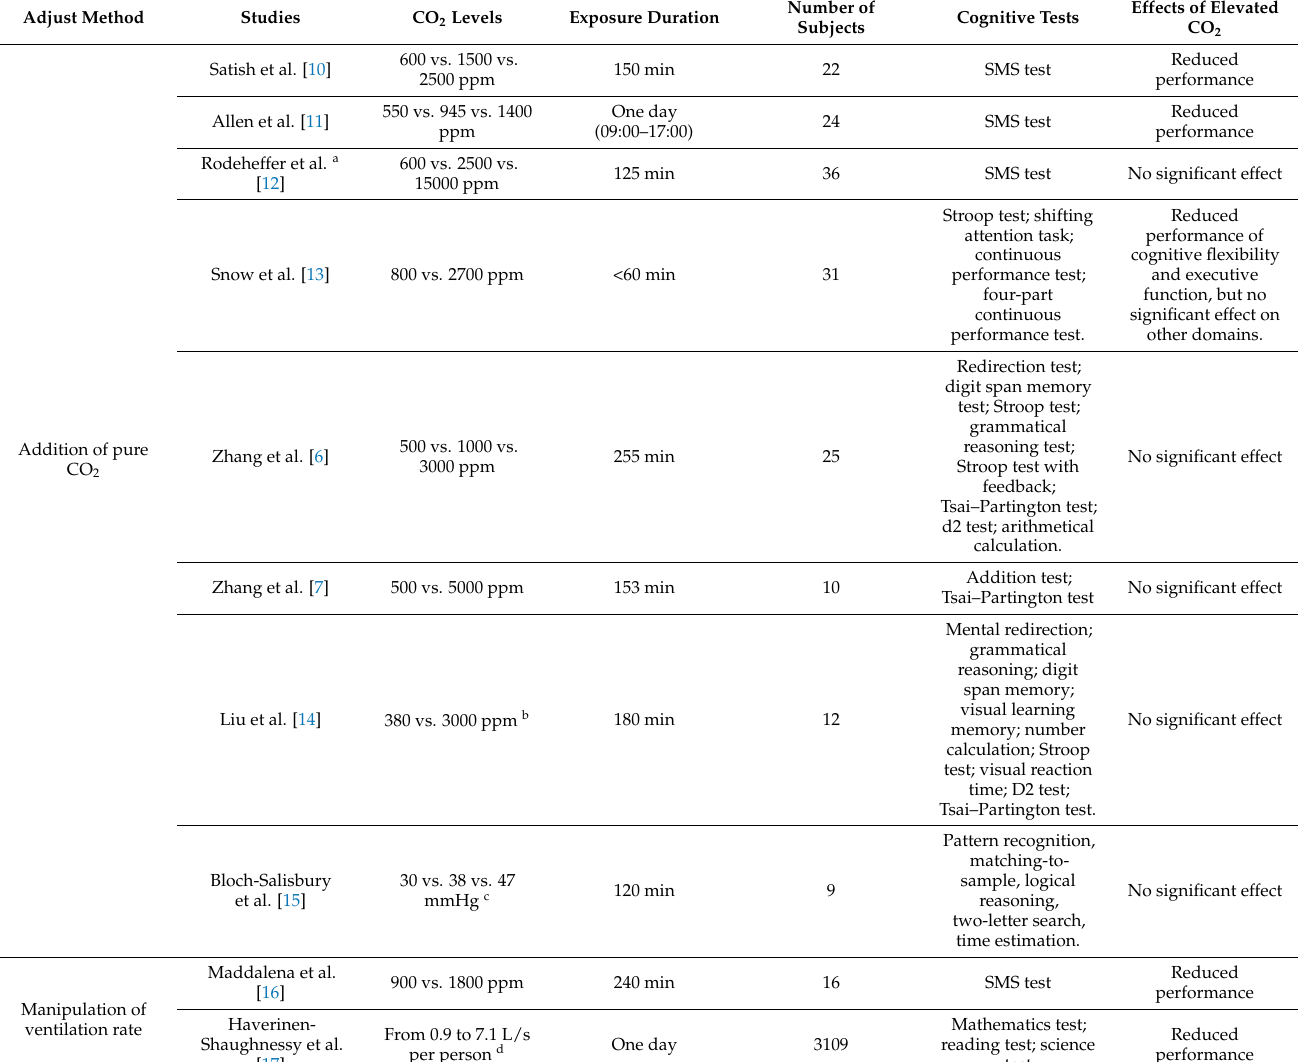
Table 1. Summary of studies examining CO 2 effects on human cognitive